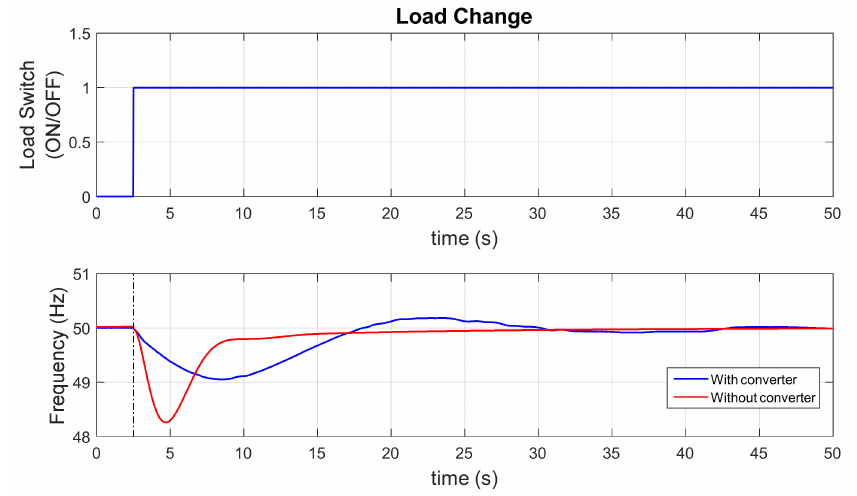
Figure 17. Comparison of frequency response with and without Grid-Forming